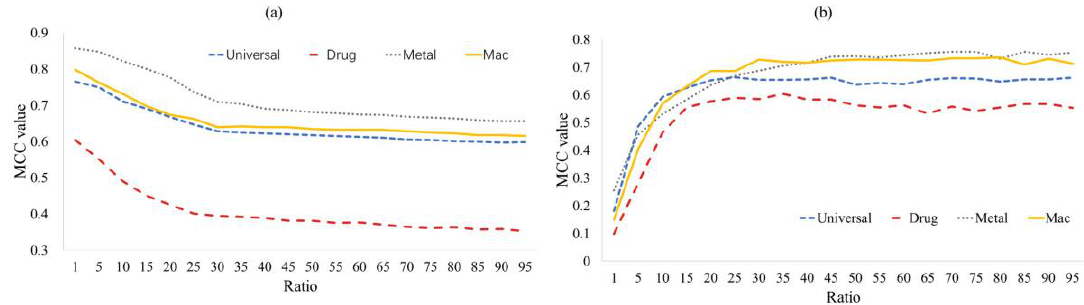
Figure 4. The tendency of MCC value as the ratio of non-binding residues and binding residues increase over ( a ) 10-fold cross-validation test and ( b ) independent validation test.